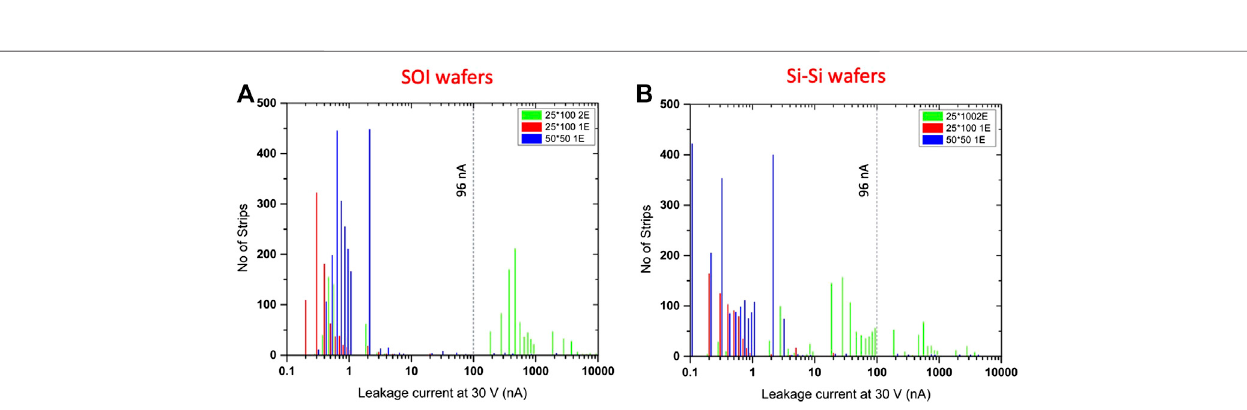
FIGURE 11 | Distributions of leakage current at 30 V reverse bias in all 3D strips (1,540 pixels each) from (A) SOI wafers, and (B) Si-Si wafers of batch 2.